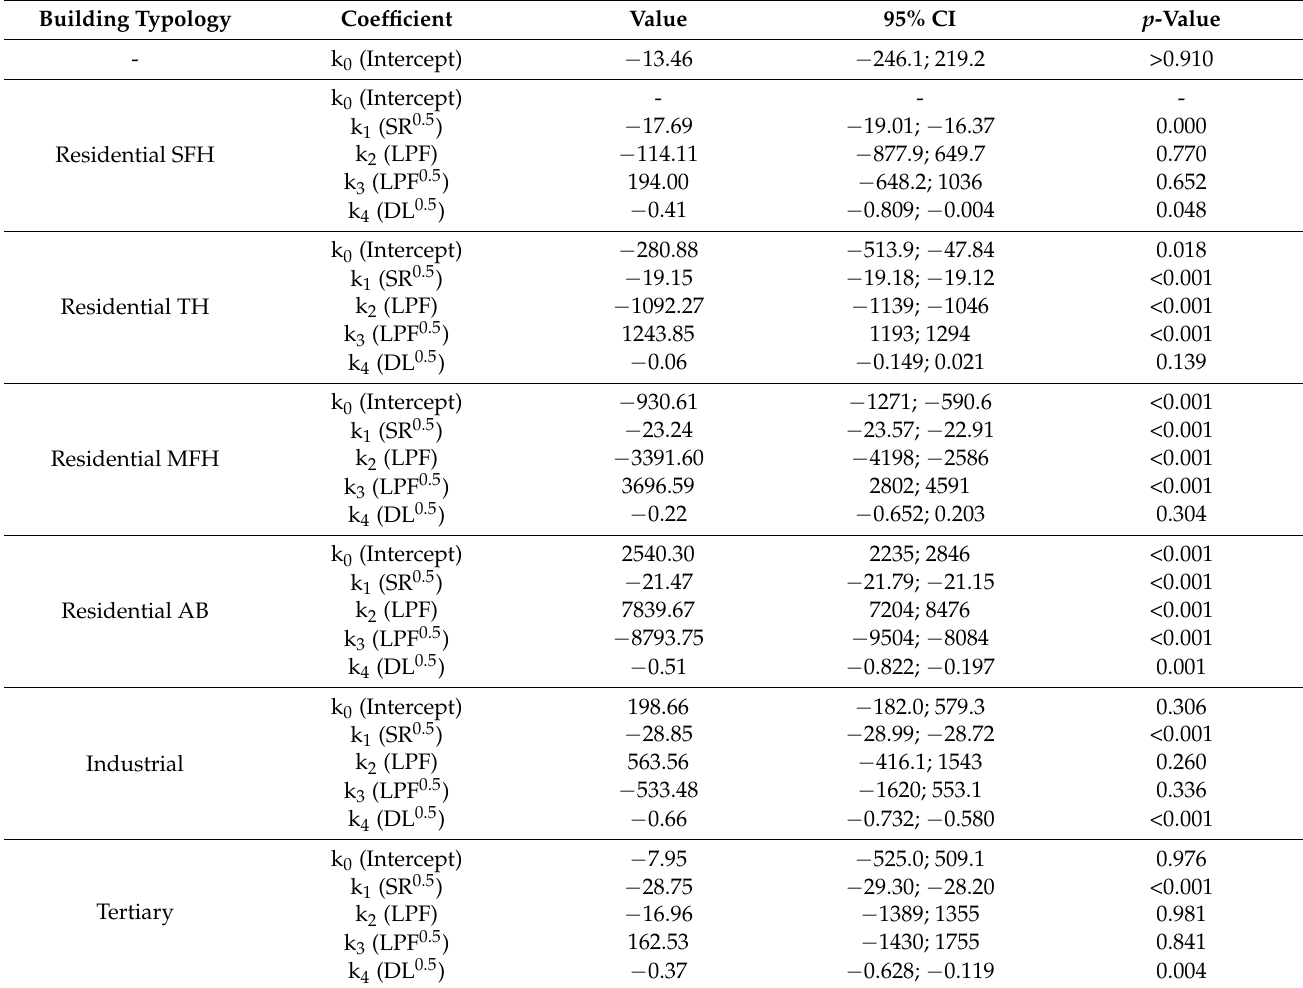
Table A1. QR coefficients to estimate SS for each building